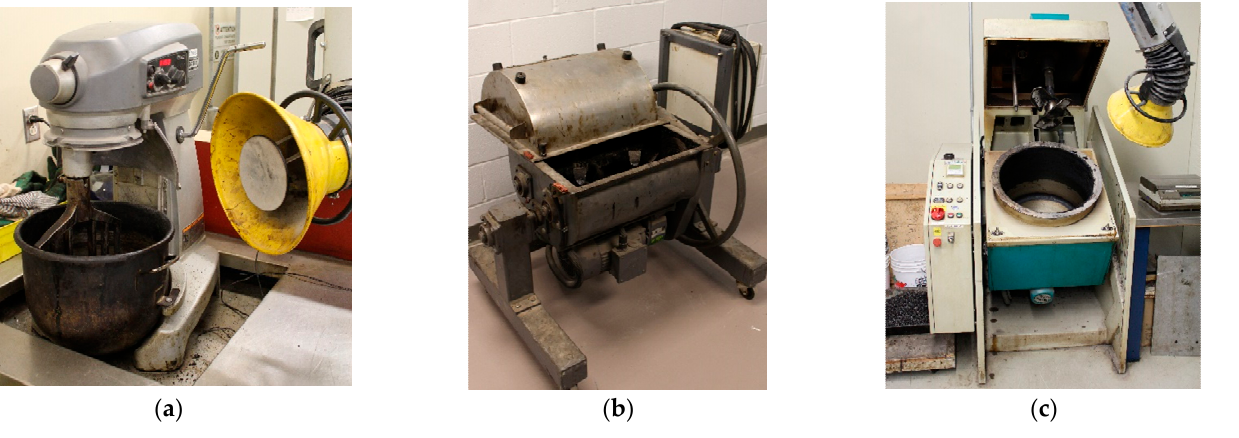
Figure 3. Mixers used for the study: ( a ) countertop mixer (HB); ( b ) pugmill mixer (PM); ( c ) ther- moregulated mixer (TR). Table 4. Conditioning of materials before mixing, mixer type, and mixing